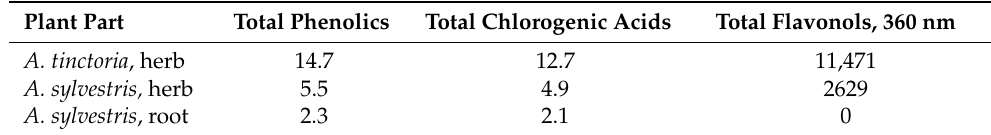
Table 5. Total phenolics in mg/g of respective plant material, estimated by area under UV– chromatogram (AUC) at 280 nm and total chlorogenic acid and derivatives in mg/g, estimated by AUC at 330 nm, using chlorogenic acid as standard in both cases, and total flavonol content by area under the chromatogram at 360 nm which is specific for the flavonols absorption spectrum maximum.